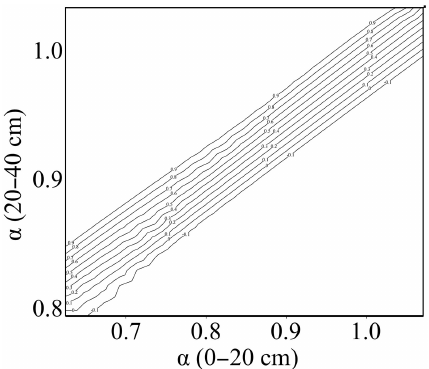
Figure 11. Multifractal spectra of joint distribution of SWS at 0– 20 and 20–40cm measured on 22 October 2008. Contour lines show the joint scaling dimensions of the SWS measurement